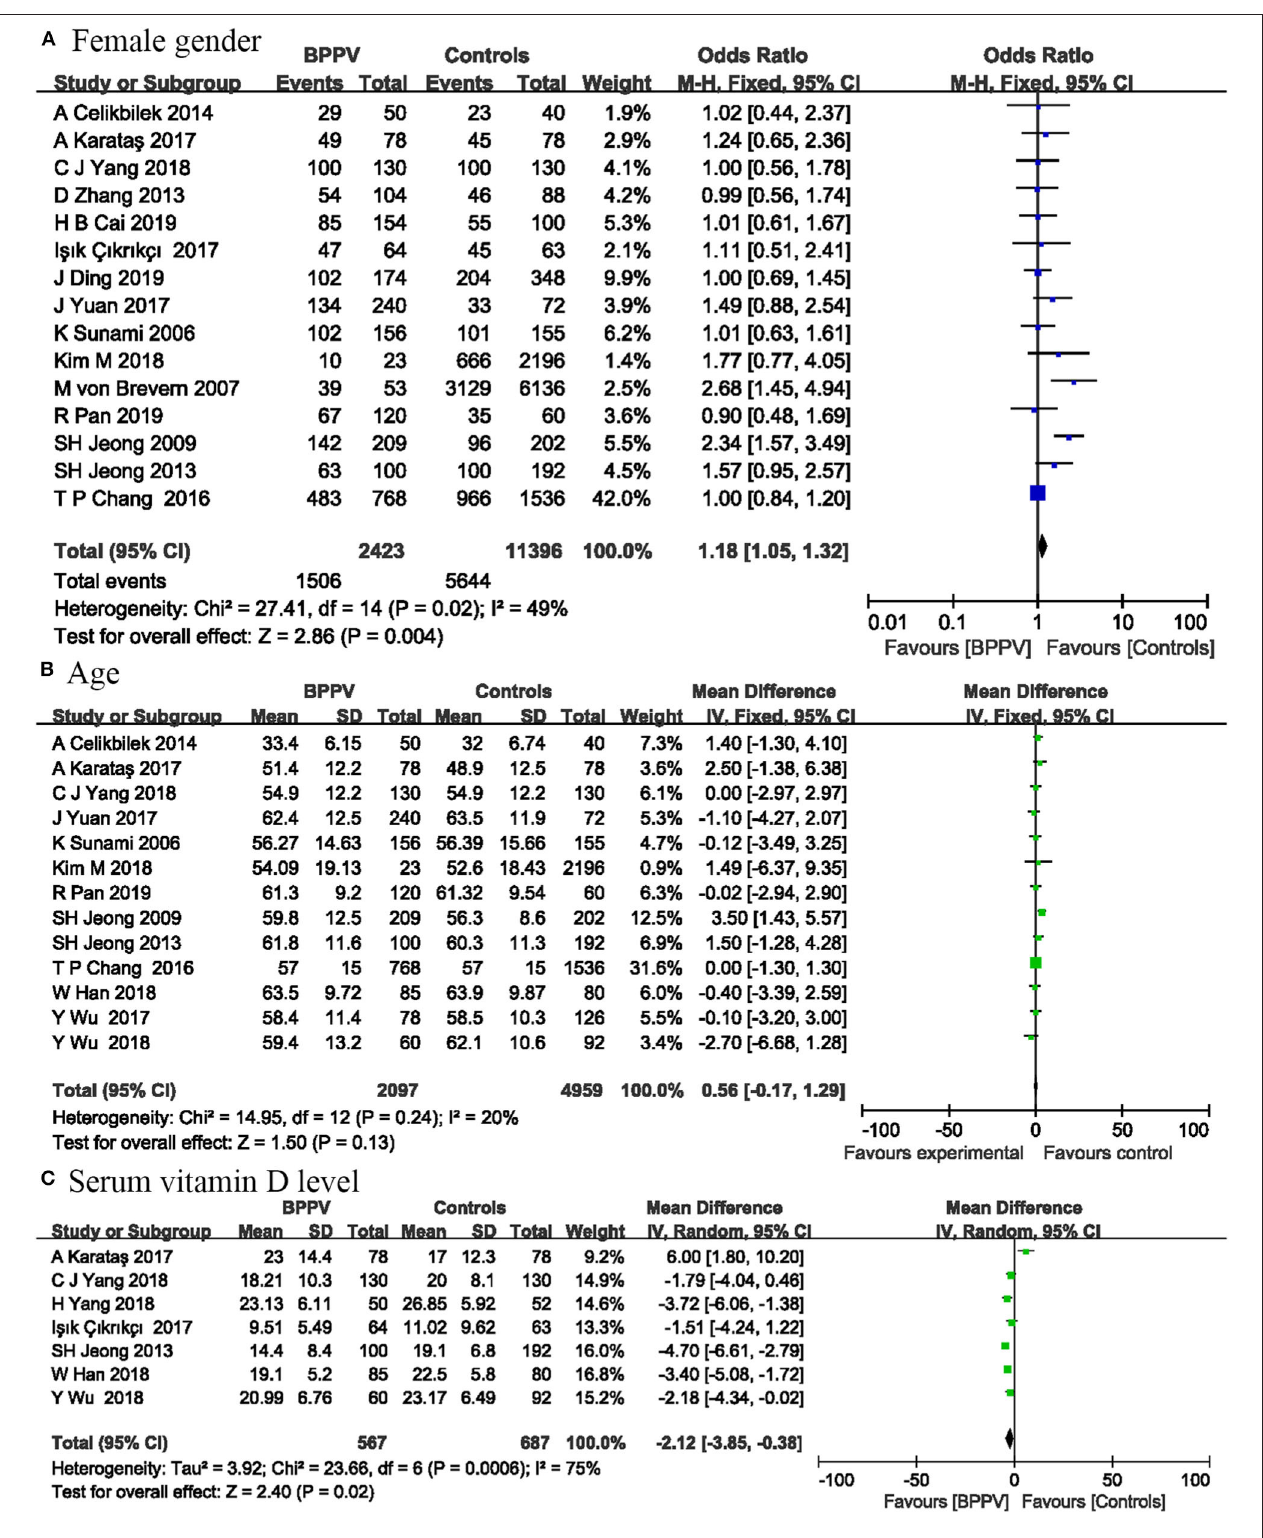
FIGURE 1 | Forest plot of female gender (A) , age (B) , and serum vitamin D level (C) .